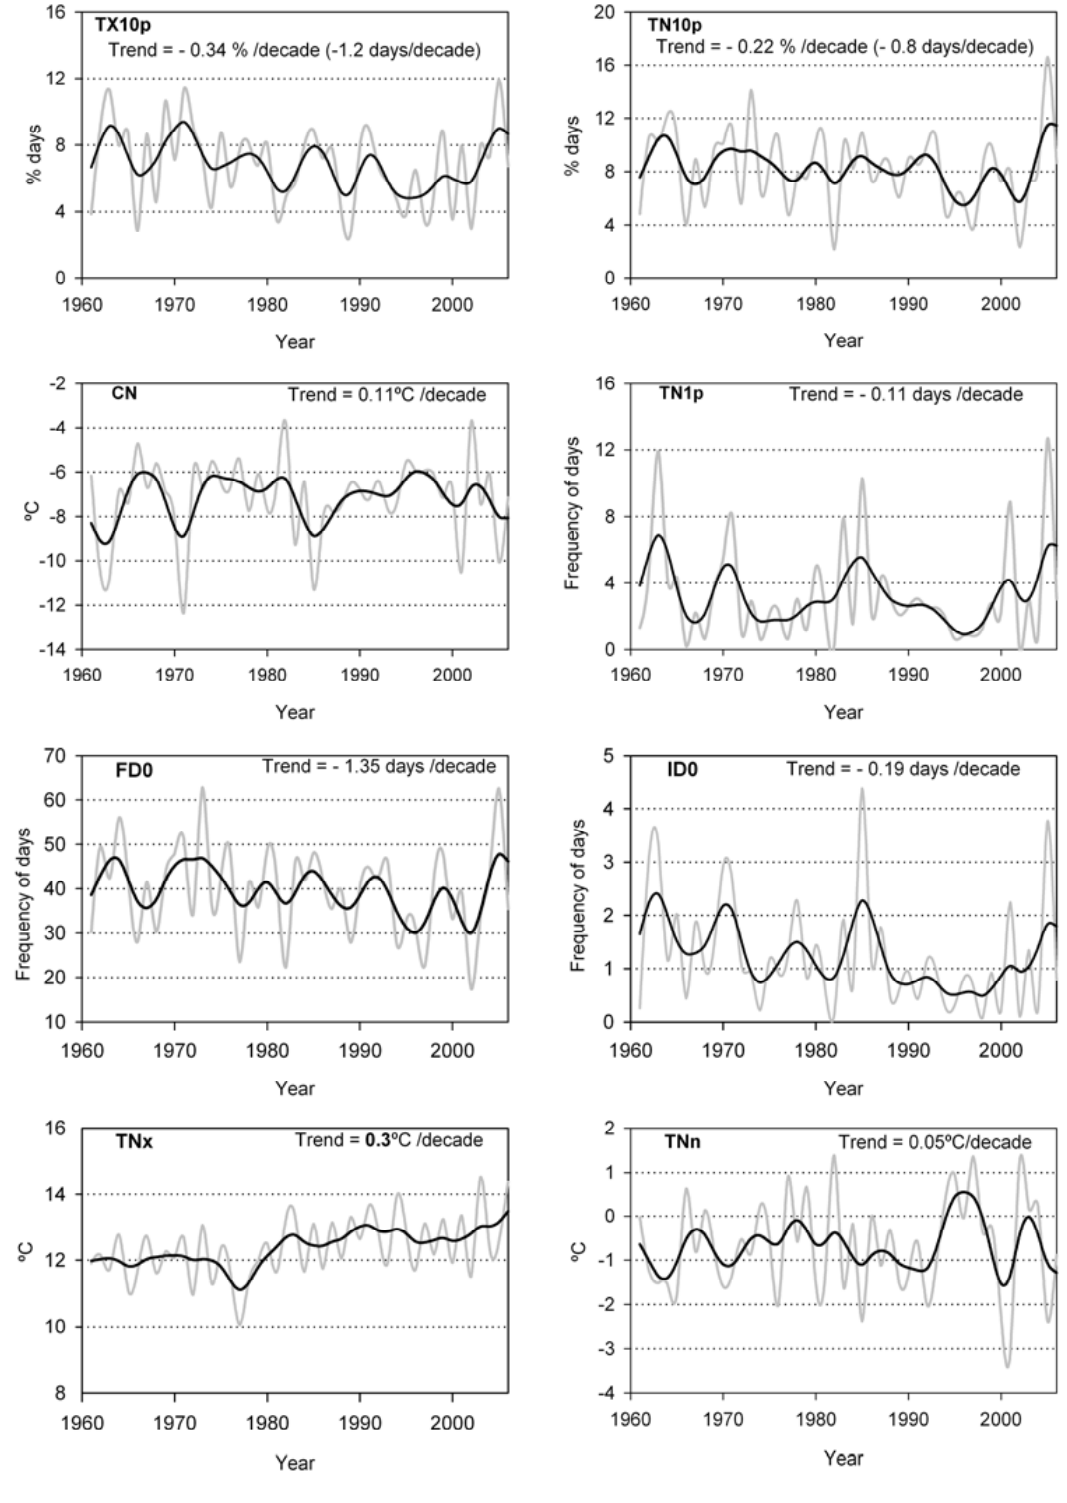
Figure 9. The same as Figure 7, but for cold extreme indices. Fig. 9. The same as Fig. 7, but for cold extreme indices.